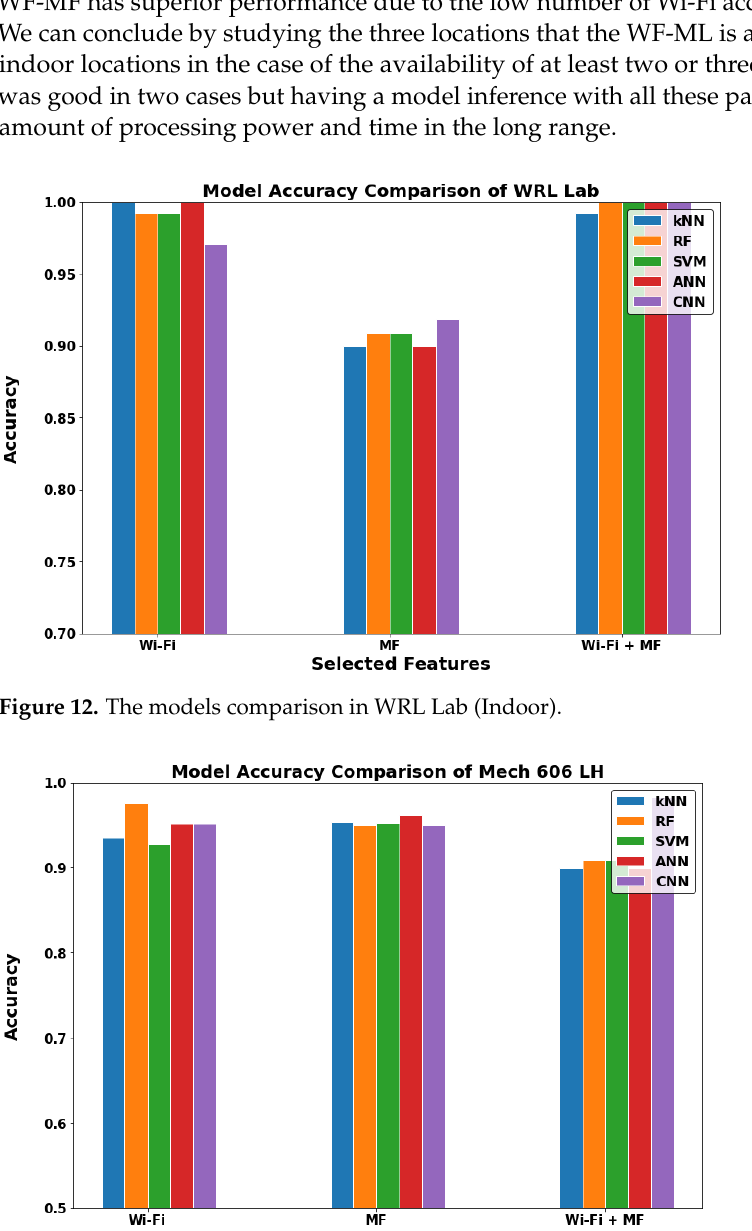
Figure 14. The models comparison in Lecture Hall 26 (Indoor). The buildings or the outdoor environment layer in Figures 15 – 17 can now be dis- cussed. In the communications department building and Neo Lecture Halls building, the MF-ML have noticeably higher performance. The mechanical department building had better performance with WF-MF. It is important to note that most of the outdoor environ- ments lack the presence of Wi-Fi coverage. Therefore, we did not get good results with WF-MF or WF-ML as in the first two locations discussed. Thus, we can conclude that MF- ML is the best model for the buildings (outdoor) locations.